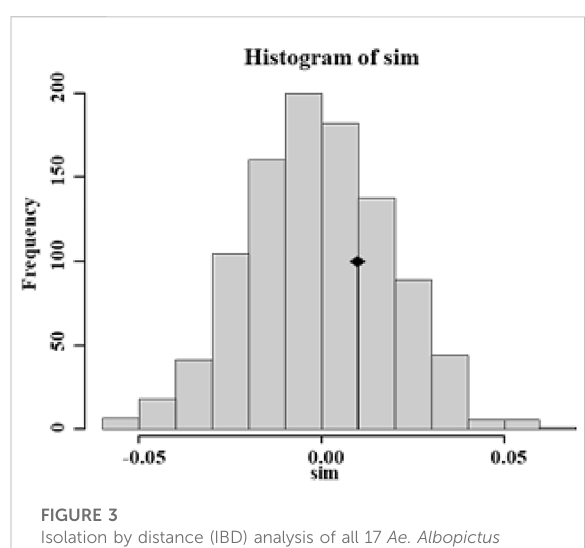
FIGURE 3 Isolation by distance (IBD) analysis of all 17 Ae. Albopictus populations from urban, urban fringe, and rural areas of Nanjing